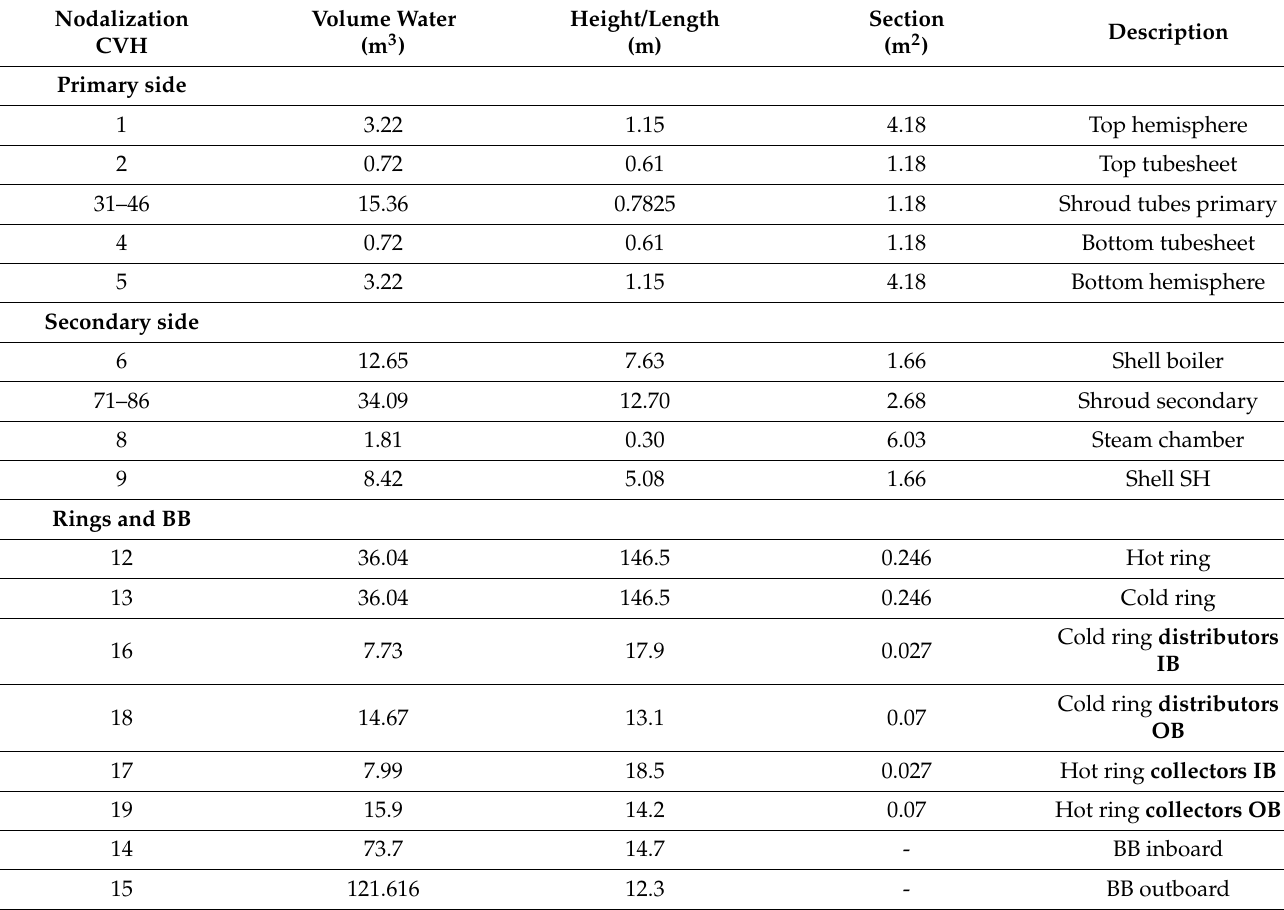
Table 11. CVH number and characteristics.